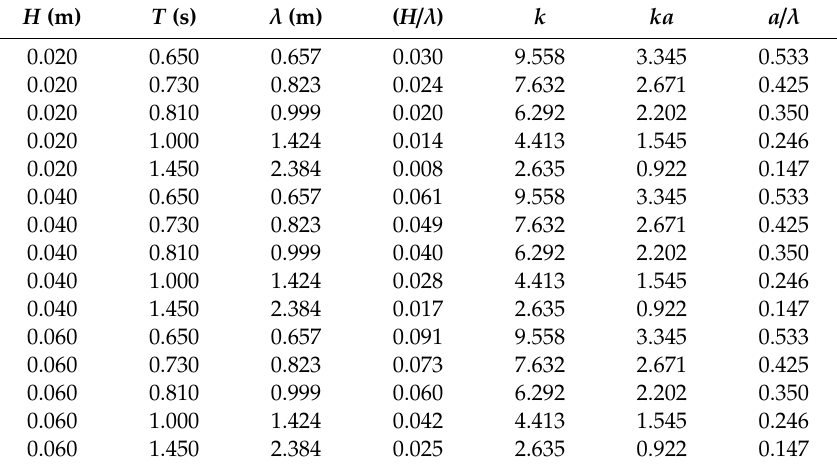
Table 4. Characteristics of generating waves (depth of water a = 0.35